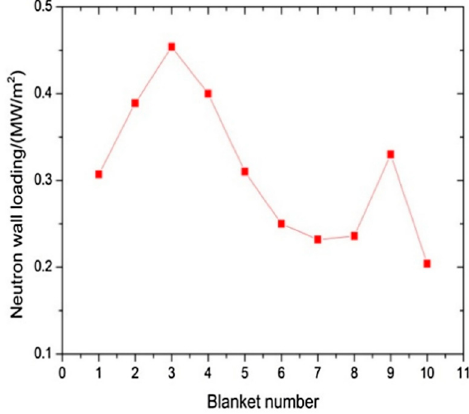
Figure 12. NWL on each WCCB blanket module.